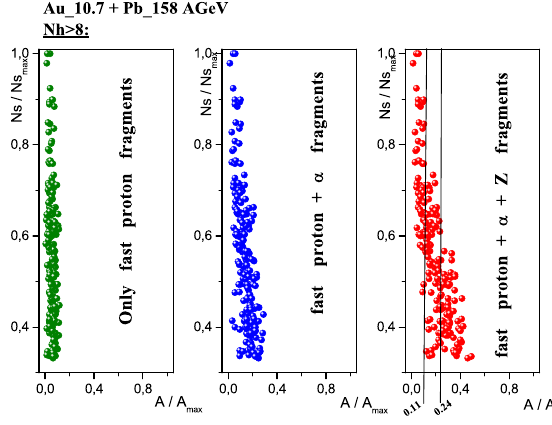
Figure 1. Multiplicity-fragmentation correlations for (Au, Pb) + (Ag / Br)